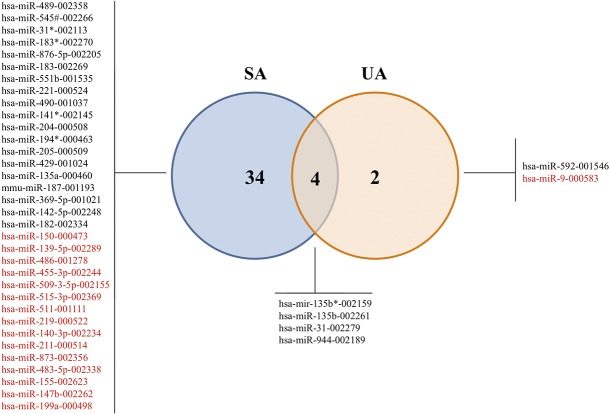
A Venn diagram showing microRNA signatures in ameloblastoma types.Significantly deregulated microRNAs (adjusted p-value <0.05 and FC ≤0.5 or ≥2) within the two groups compared with control group. Upregulated in black and downregulated in red color.